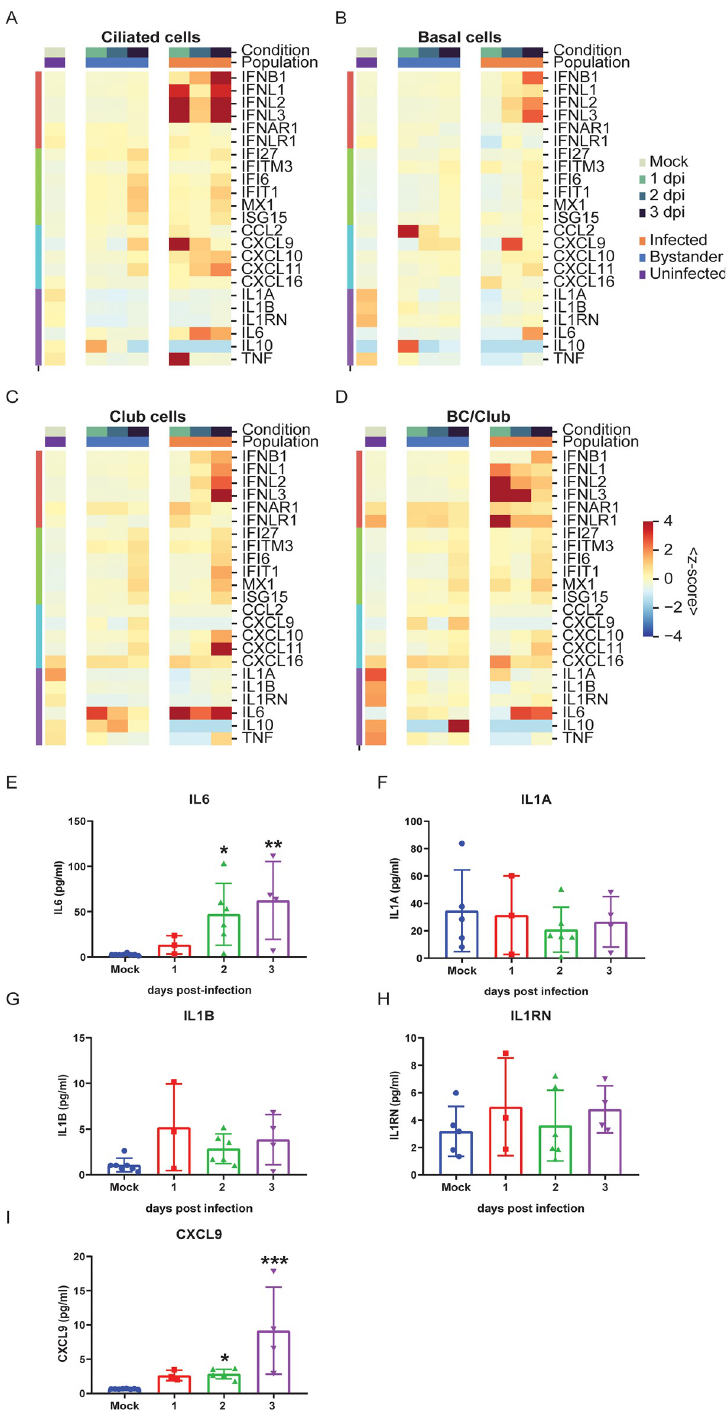
Fig 5. SARS-CoV-2 infection induces a robust innate immune response. (A–D) Heatmaps showing average expression (represented as z-score) of key innate immune and inflammatory genes in ciliated (A), basal (B), club (C), and BC/club cells (D) in infected, bystander, and uninfected cells in different time points (color bar legend atop heatmaps). Rows index average expression for type I and III IFNs and chemokines (left color bar legend). The individual numerical value per condition for A–D is listed in S1 Data. (E–I) Cytokine and chemokine measurement in basolateral supernatants of HBEC cultures infected with SARS-CoV-2 at 0 (mock), 1, 2, and 3 dpi from 3